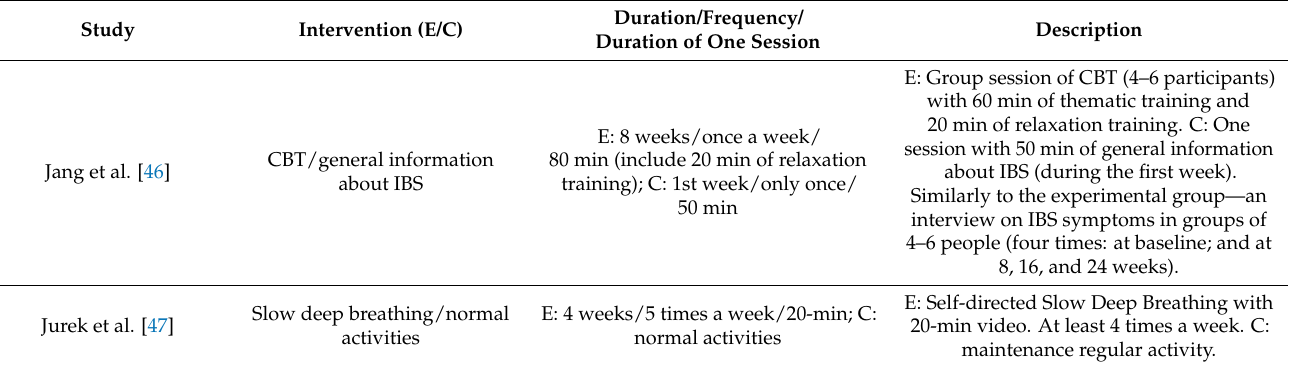
Table 2 expands on the description of the applied intervention for the experimental and control groups. Table 2. Characteristics of the experimental interventions used to treat IBS